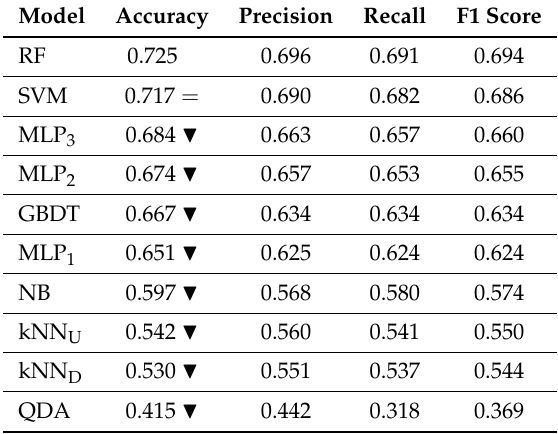
Table 3. Averaged results for the experiment that considers all the features. Model